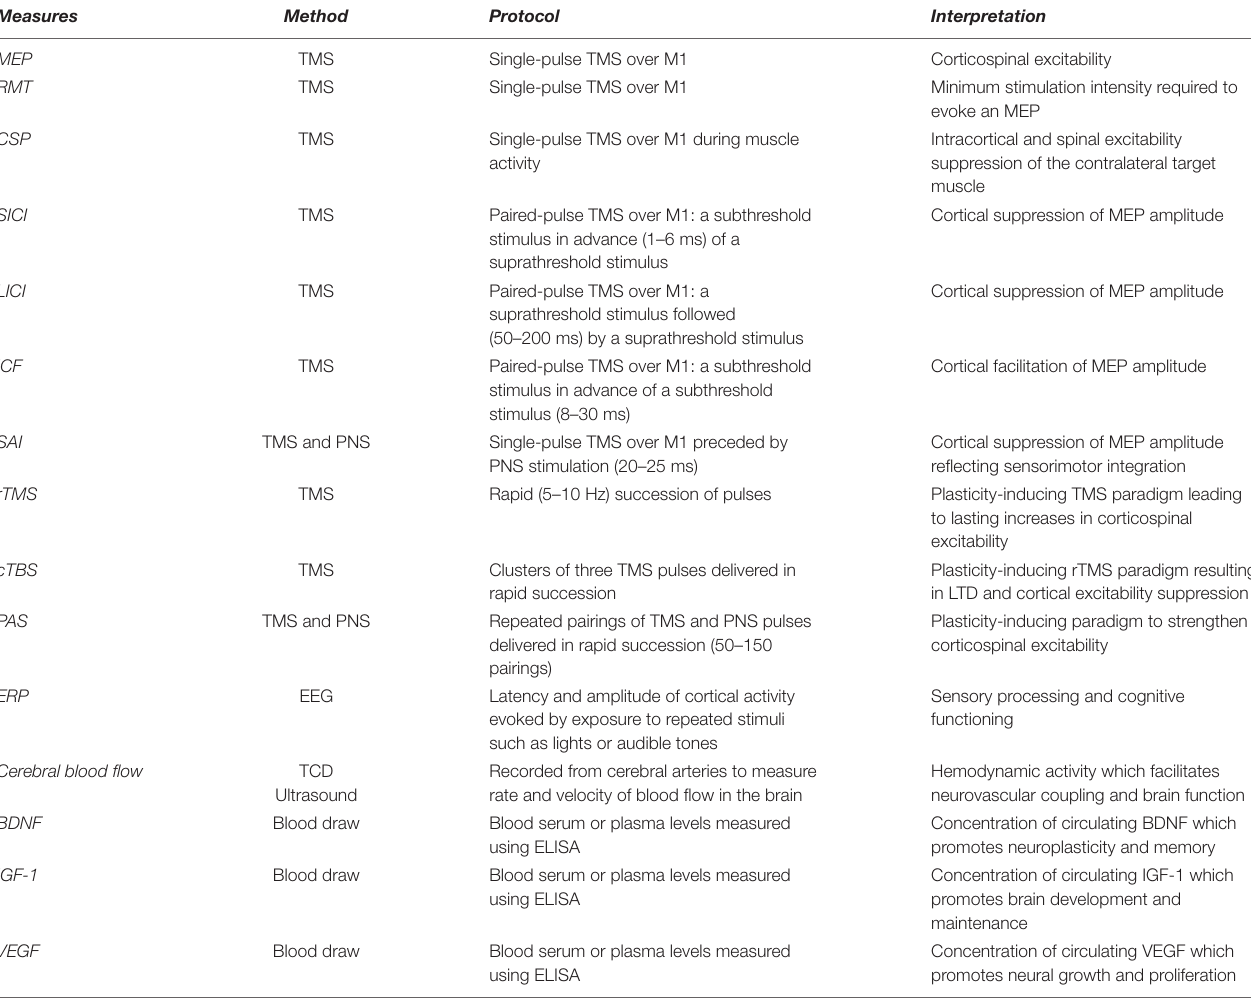
TABLE 1 | Neurophysiological and molecular measures of neuroplasticity.